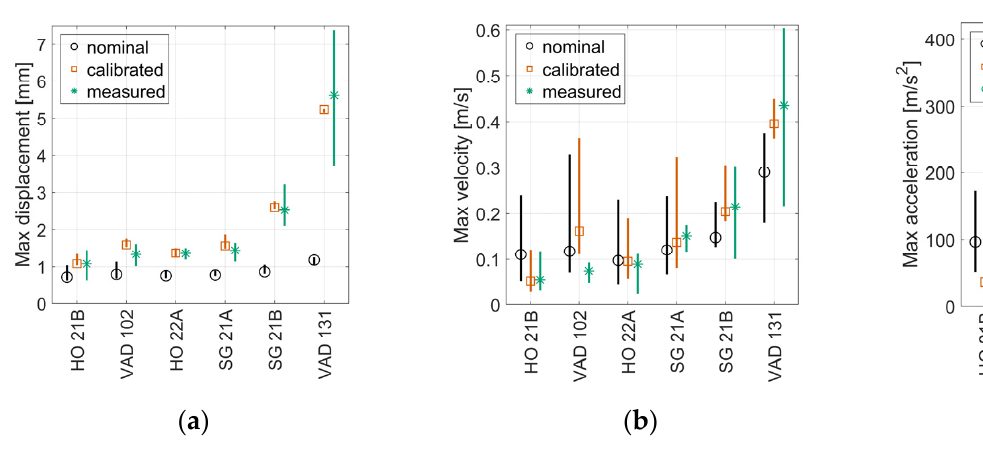
Figure 21. Comparison between maximum measured and simulated sleeper responses (mean value marker, full range vertical line) for ( a ) displacement, ( b ) velocity, and ( c ) acceleration. Simulated results with either nominal (o-black) or calibrated track model parameters ( □ -orange); train speed 160 km/h for HO 21B, SG 21A, and SG 21B; 190 km/h for HO 22A, VAD 102; and 130 km/h for VAD 131; and 19 different wheel profiles. Measured results from 20 signals (*-green) recorded at similar train speeds as in the simulations. Data are low-pass-filtered at 250 Hz.